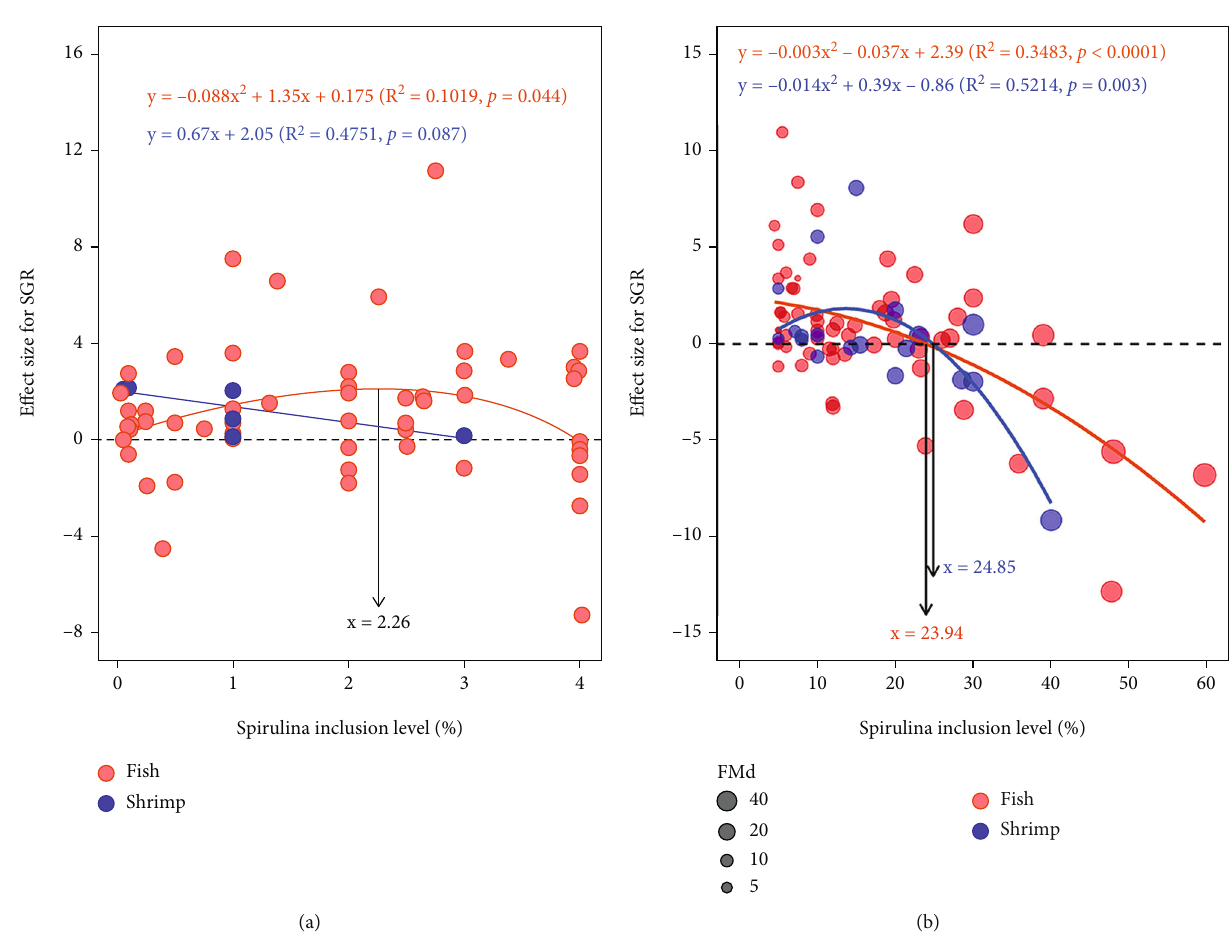
Figure 4: Random-e ff ects model regression of spirulina meal inclusion level as a feed additive (a) and feed ingredient (b) on the e ff ect size of SGR. The circle size represents the replaced level (%) of fi shmeal by SPM, in other words, it means the di ff erence of fi shmeal content between the control group and SPM supplemented